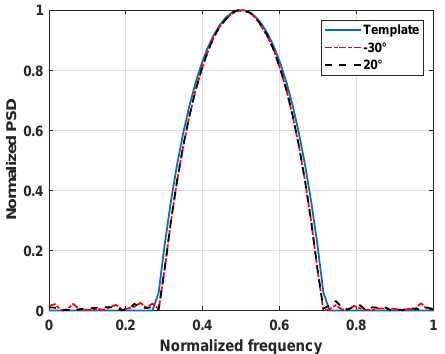
Figure 5. The PSDs of AWs.